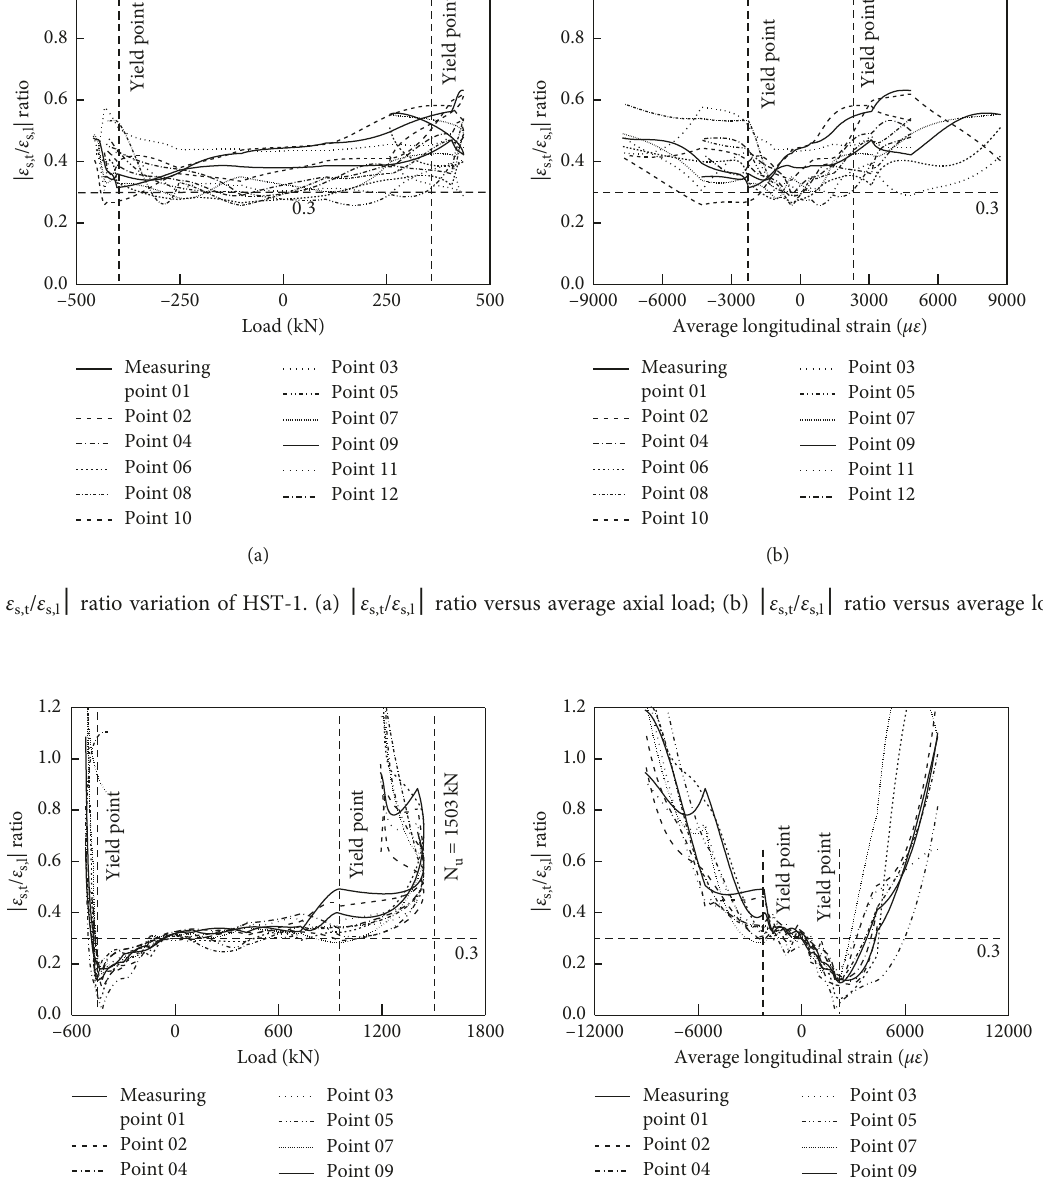
│ ratio variation of CFST-3. (a) │ ε